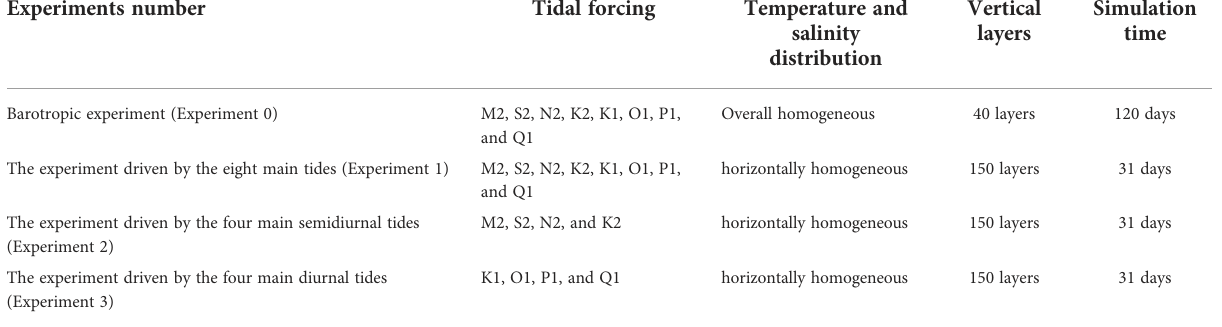
TABLE 1 The con fi gurations of different numerical